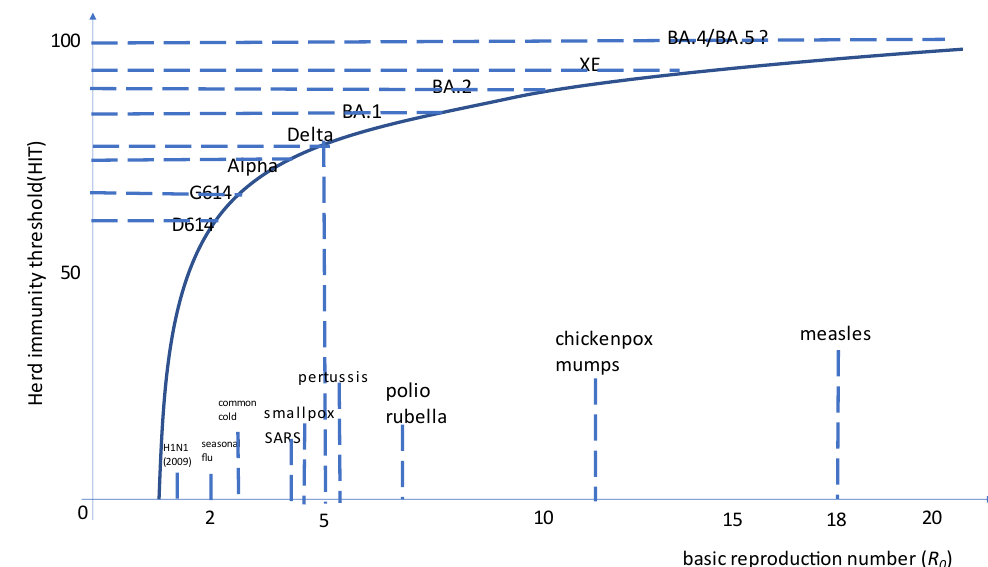
Figure 2. Basic reproductive number ( R 0 ) and estimated herd immunity threshold for SARS-CoV-2 variants of concern and the XE recombinant compared to other human pathogens. Please note herd immunity cannot be currently achieved with the current generation of systemically delivered vaccines